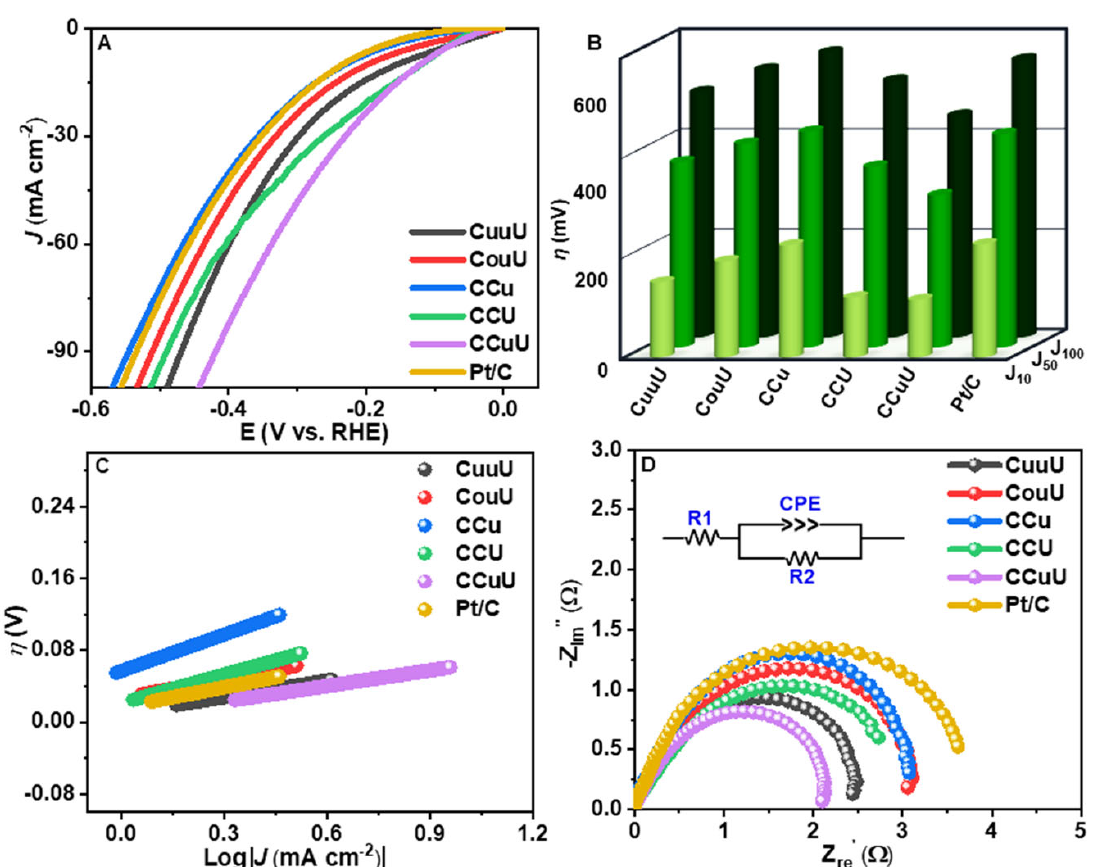
Figure 4. ( A ) LSV plots, ( B ) Comparison of overpotentials at different current densities, ( C ) Tafel plot, and ( D ) EIS diagram (inset: EEC) of catalysts in alkaline NaCl solution (1 M KOH + 1 M NaCl). Table 1. Account of the catalytic activities of the materials in the alkaline NaCl solution.